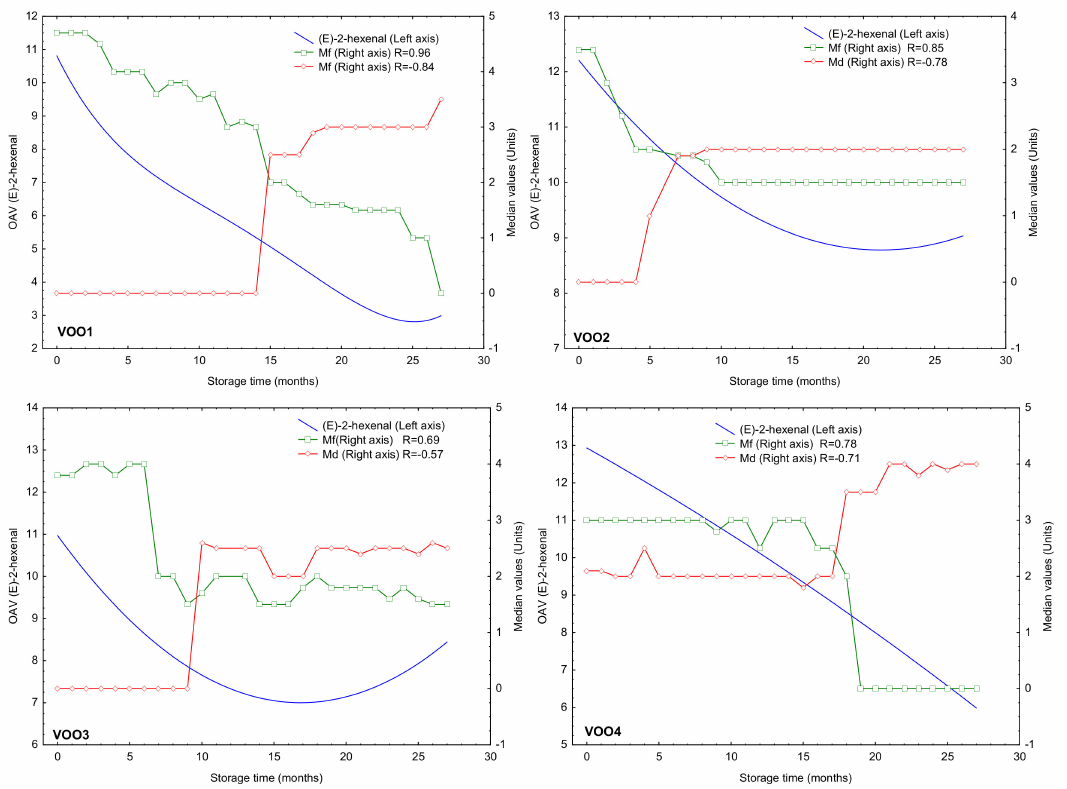
Figure 3. Median of the fruity attribute (Mf), median of defect (Md) and ( E )-2-hexenal OAV (odor activity value) of the four virgin olive oils (VOO) during the storage experiment. The regression coe ffi cients (R) between Mf and Md in relation to the OAV of ( E )-2-hexenal are